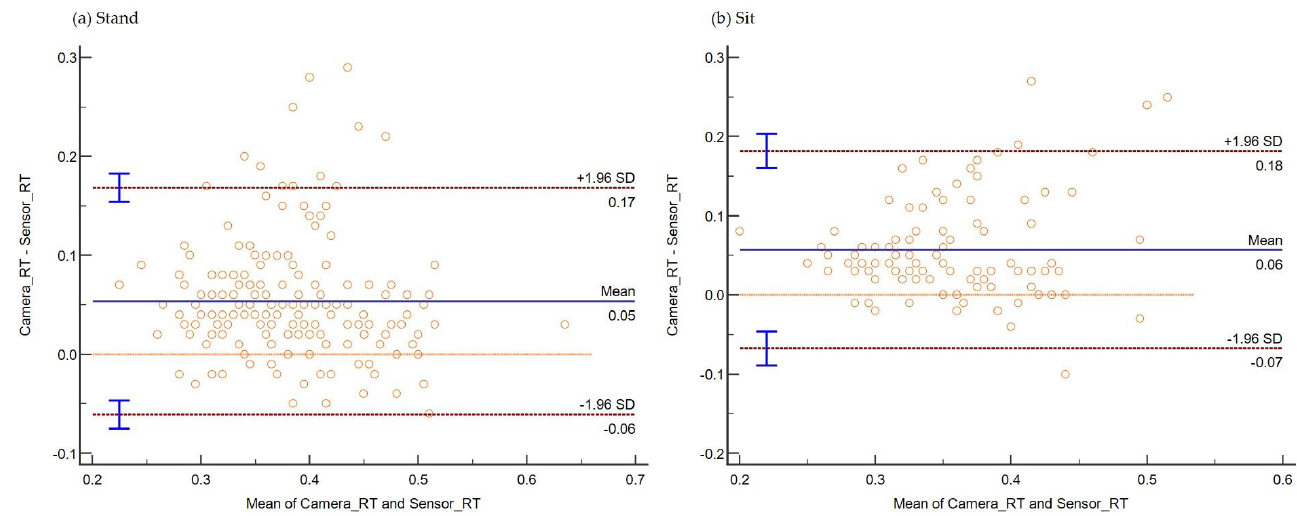
Figure 6. Plot differences between the camera and sensor systems RT versus the mean of two measurements during ( a ) standing and ( b ) sitting. The camera system reported a longer mean RT (bias) during standing by 0.05 s and sitting by 0.06 s. Table 2. Bias, 95% Confidence Interval of Bias, Lower Limits of Agreement (LOA), 95% CI of lower LOA, Upper LOA, 95% CI of Upper LOA from Bland – Altman plots.